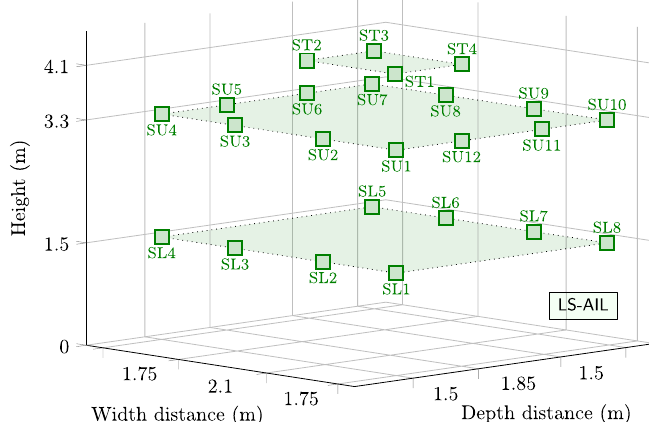
Fig. 5 View of the LS-AIL loudspeaker array in the AIL. A description of the loudspeaker labels is given in Table 2. The speakers are organized in three different height levels of about 1.5 m (lower level), 3.3 m (upper level), and 4.1 m (top level) above the floor. The axes limits coincide with the boundaries of the approximately shoe-boxed shaped room, cf. Section 2.2. On the horizontal axes, the approximate distance between neighboring speakers is indicated. The given dimensions are of indicative nature and not exact; for extracting the coordinates of the microphone and loudspeaker positions, the MATLAB or Python scripts discussed in Section 6.2 should be